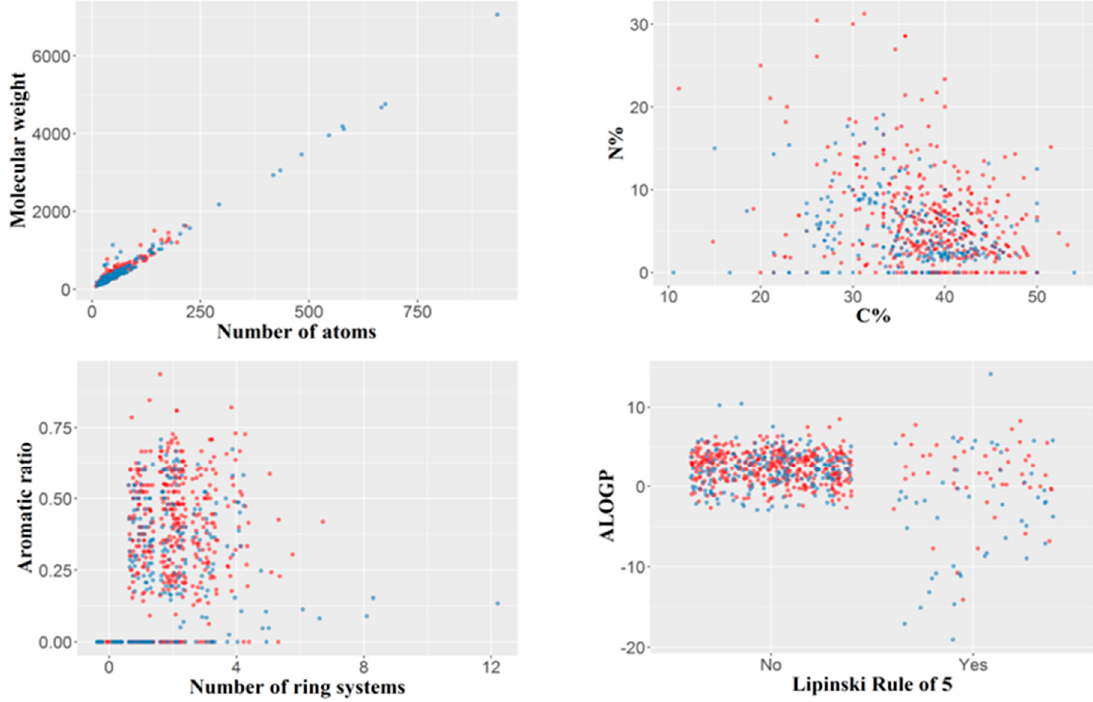
Figure 1. Variability of the dataset illustrated by several simple constitutional descriptors or molecular properties. Blue: compounds of no concern; red: compounds of hepatotoxicity concern. For the Lipinski rule of five, “No” indicates the compounds with no violation of the rule, and “Yes” those violating the rule.